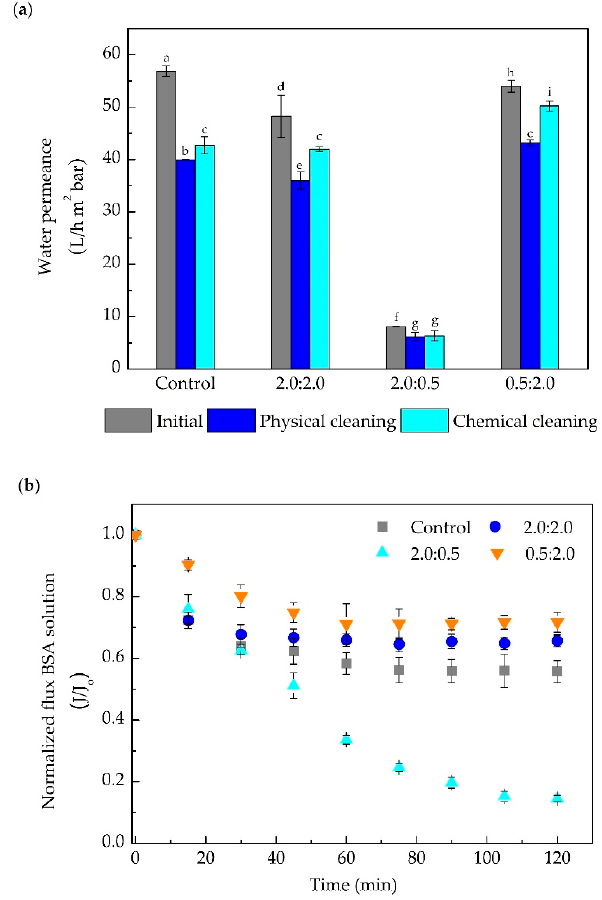
Figure 5. Performance of control and modified UH050 membrane with di ff erent concentrations of DA:PEI (2.0:2.0; 2.0:0.5, and 0.5:2.0 mg mL − 1 ) in the filtration of BSA solution (2.5 g L − 1 ). ( a ) Water permeance before the protein filtration (initial) and after the physical and chemical cleaning. ( b ) Normalized permeate flux of the BSA solution. Bars with di ff erent letters show a statistical di ff erence ( p <